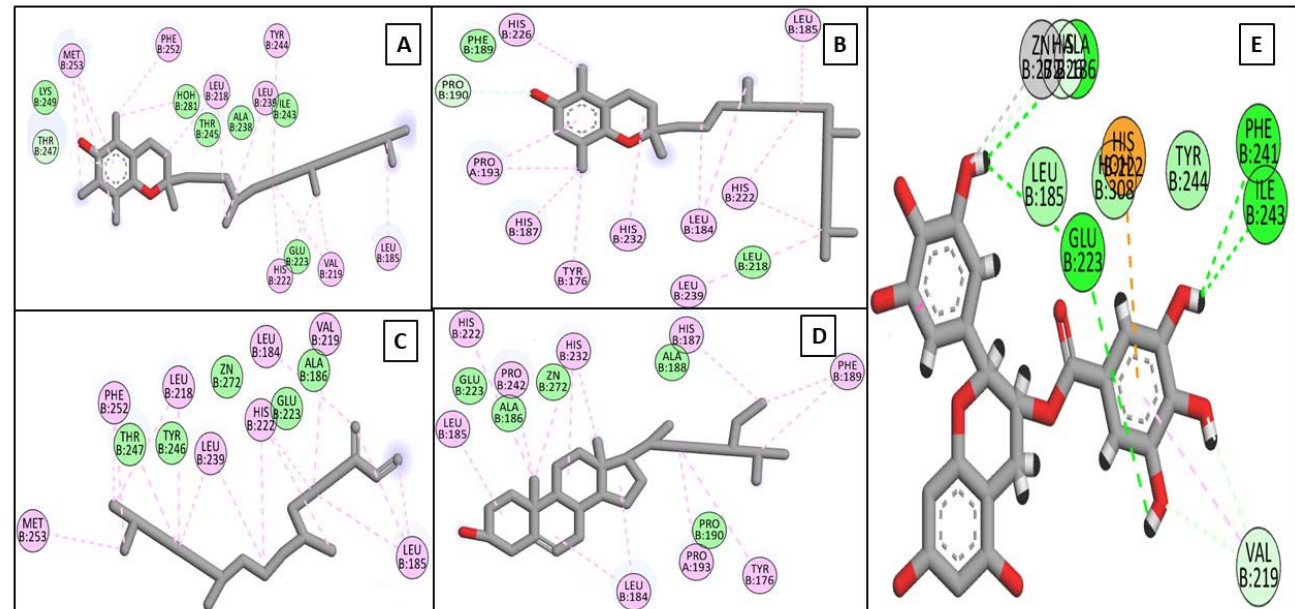
Figure 4. 2D binding modes of α -tocopherol ( A ), β -tocopherol ( B ), neophytadiene ( C ), γ -sitosterol ( D ), and EGCG ( E ) to the active binding sites of collagenase.